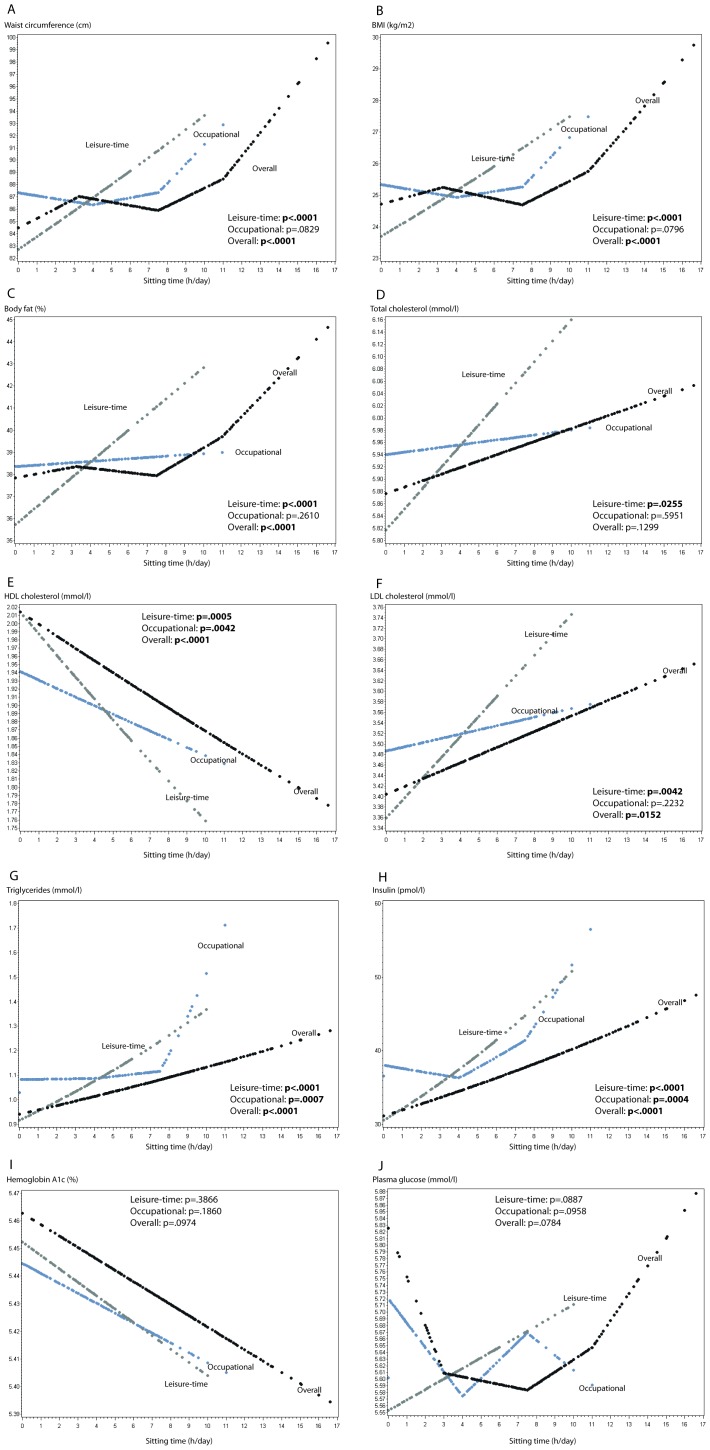
Regression plots for cardio-metabolic risk factors for leisure-time sitting, occupational sitting and overall sitting time.A Waist circumference (n=2414), B BMI (n=2412), C Body fat (n=2408), D Total cholesterol (n=2402), E HDL cholesterol (n=2269), F LDL cholesterol (n=2251), G Triglycerides (n=2269), H Insulin (n=2268), I Hemoglobin A1c (n=2273), J Plasma glucose (n=2269). P-values reported are for the effect of each sitting time domain. All p-values are rounded to four decimals. For non-linear associations restricted linear spline were used with knots at the 10, 50 and 90 percentiles of sitting time for each domain. All models included the covariates sex, age, education, smoking, alcohol consumption, diet and moderate to vigorous physical activity (MVPA). Color legend for all plots: Grey=Leisure-time sitting, Blue=Occupational sitting time, Black=Overall sitting time.